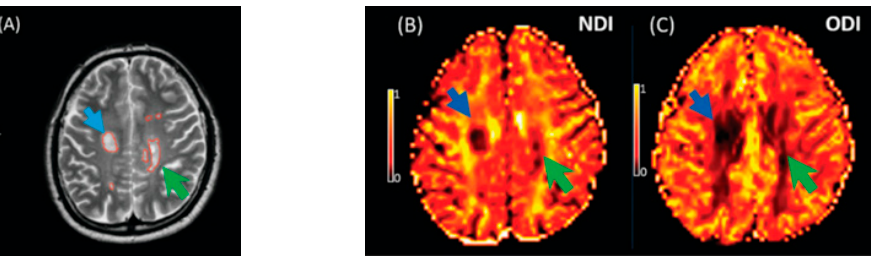
Figure 8. Illustrates NODDI metrics in a single slice of one MS subject. The MS lesion in the major white matter tracts (blue arrow) and periventricular lesion (green arrow) are marked in a structural MRI image ( A ), NDI map ( B ), and ODI map ( C ). Both the NDI and ODI are decreased in the MS lesion [20].